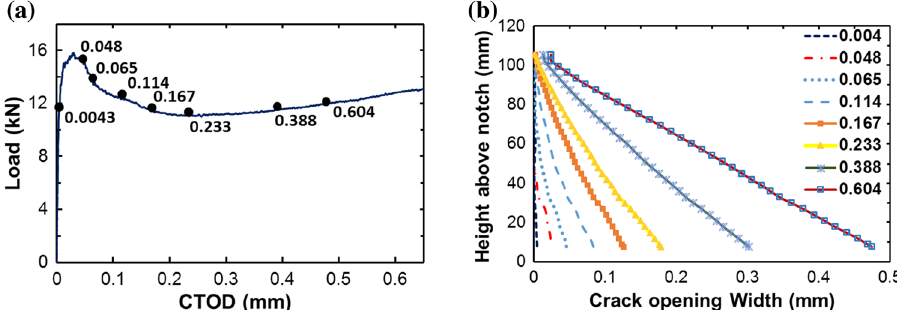
Fig. 10 Results from an SFRC50 specimen: a load-CTOD response of a typical specimen; b crack opening width as a function of height above the notch for different values of CTOD (in mm).